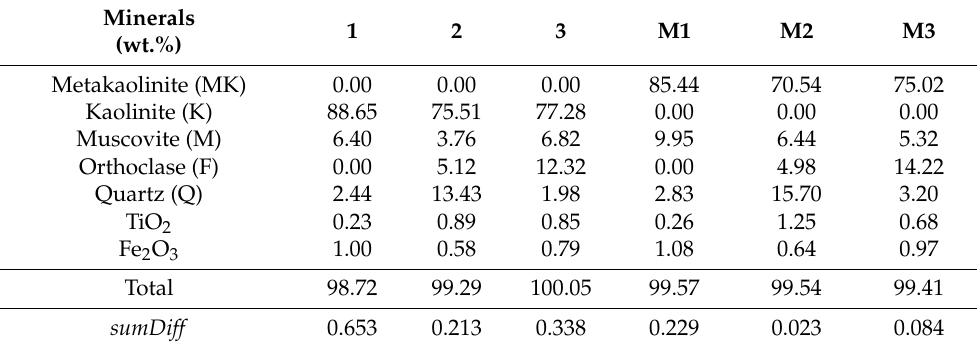
Table 4. CQMA of minerals in kaolin and metakaolin